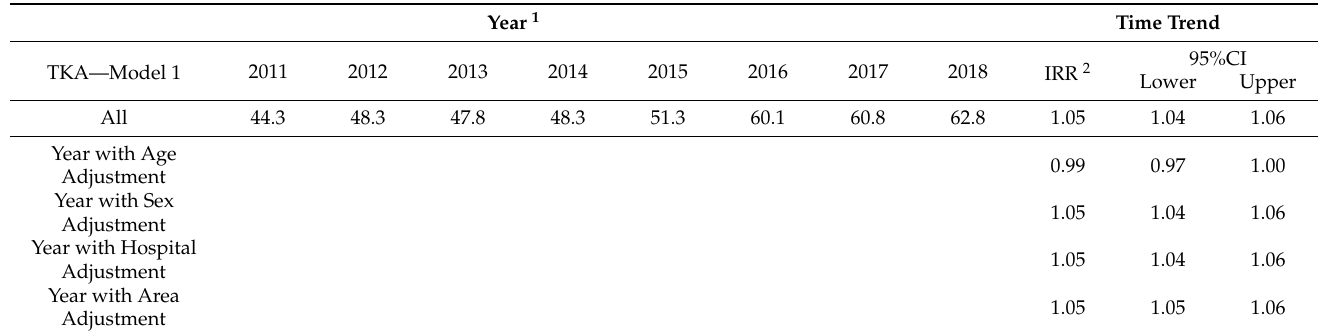
Figure 1. Overall patient trend for TKA between 2011 and 2018. Table 1. Model 1—Poisson regression analysis according to calculation of the effect size of the general time trend.